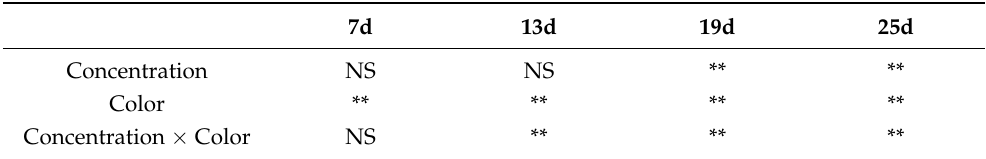
Table A3. Two-way ANOVA conducted shows the effects of concentration, color, and their interaction on the MC-LR production of M. aeruginosa